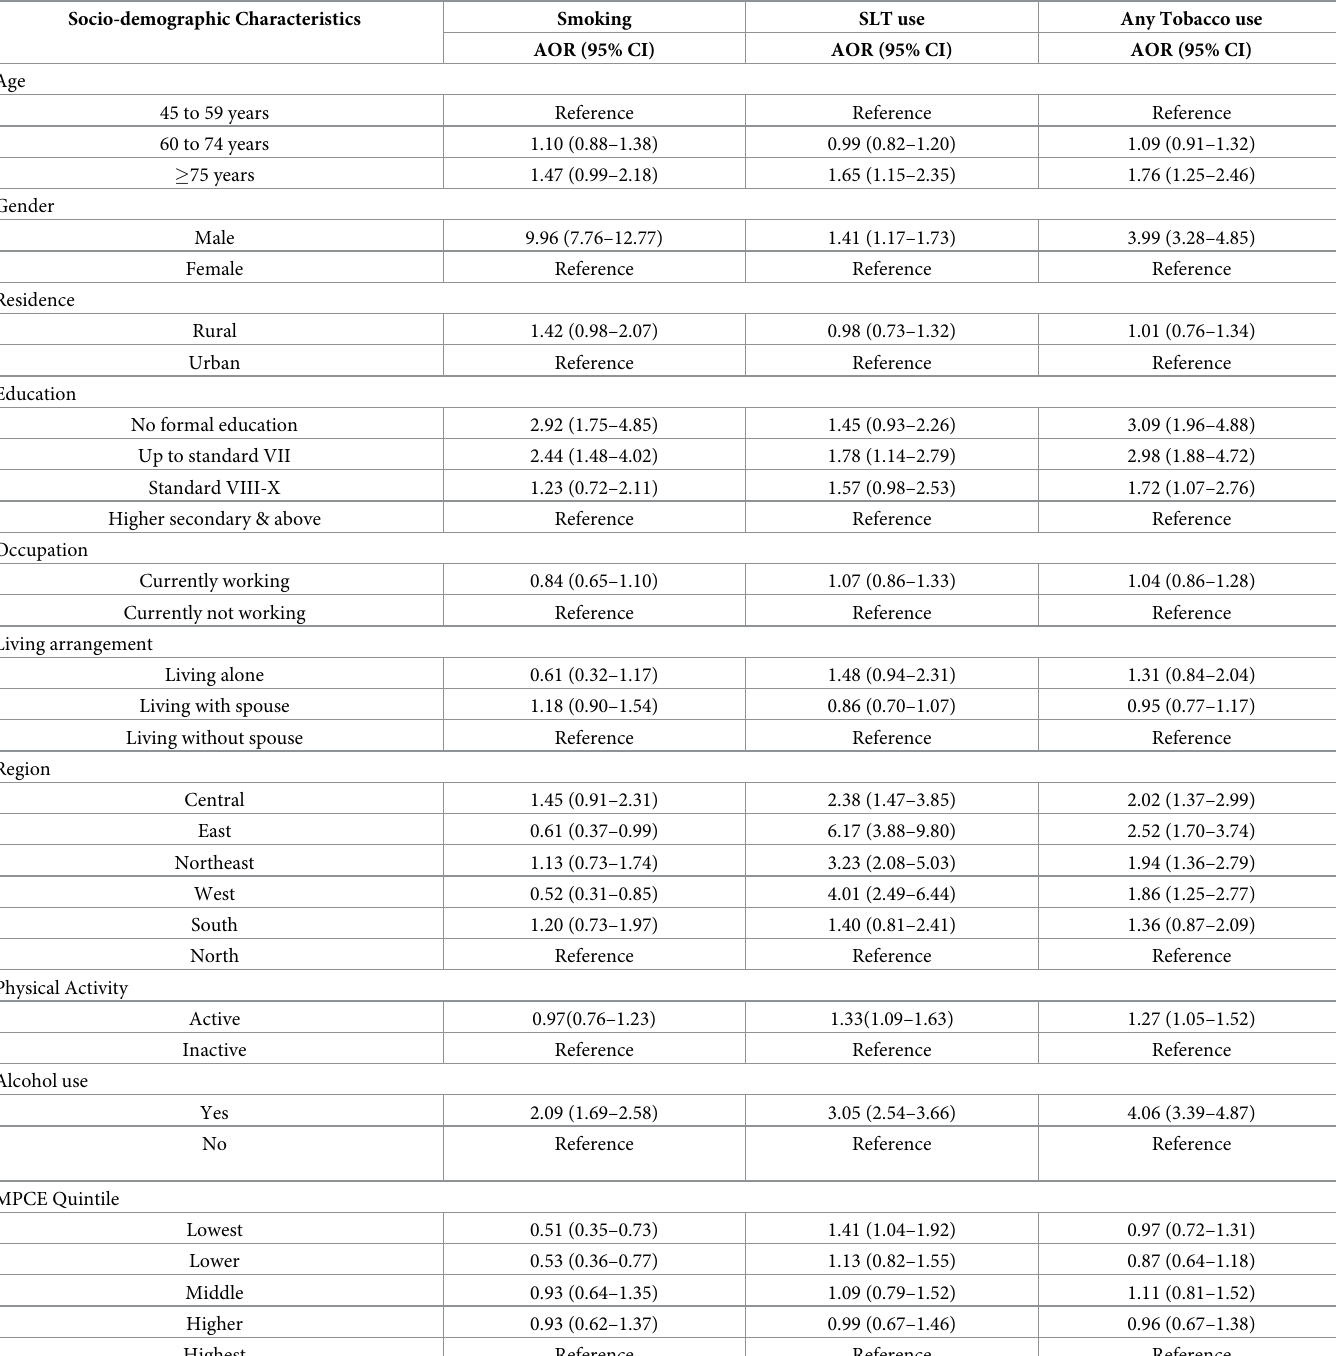
Table 3. Multivariable association between various forms of tobacco with socio-demographic characteristics. Socio-demographic